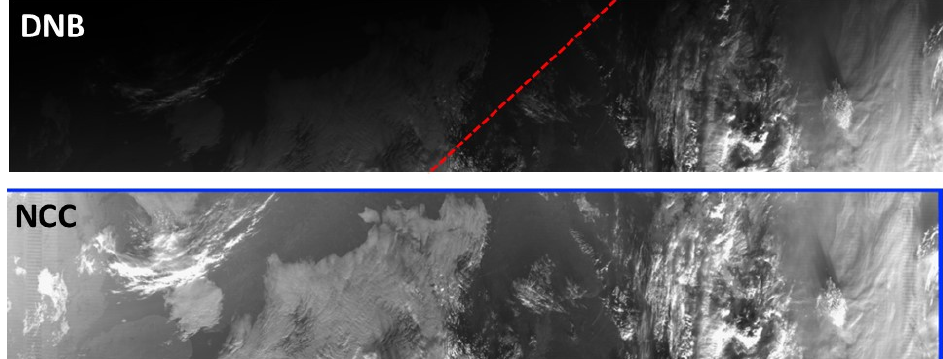
Figure 2. The difference between the DNB (SDR, top ) and NCC (EDR, bottom ) granules. Whereas the DNB is provided in units of band-integrated radiance, the NCC product is a pseudo-albedo, scaled to display features more uniformly, such as across the day-night terminator in this example. Red dashed line denotes the day-night terminator, and the blue values are EDR fill.